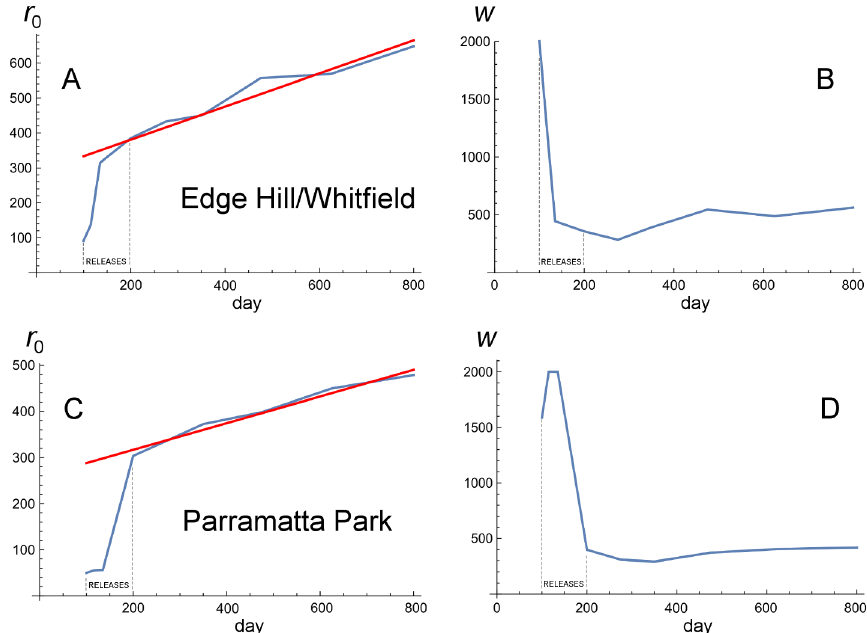
Fig 6. Estimating rates of spatial spread and wave width for Edge Hill/Whitfield (EHW) and Parramatta Park (PP). PanelsA and B plot the estimates of r 0 and w (from S2 Table)through time for EHW; panelsC and D show the estimates for PP. The x axis in each panel represents days; the releasesbegan on day 99 and ended on day 197. The slopes of the fitted regressionlines imply wave speeds of c d = 0.474 m per day at EHW and c d = 0.289 m per day at PP. See the text for discussion and